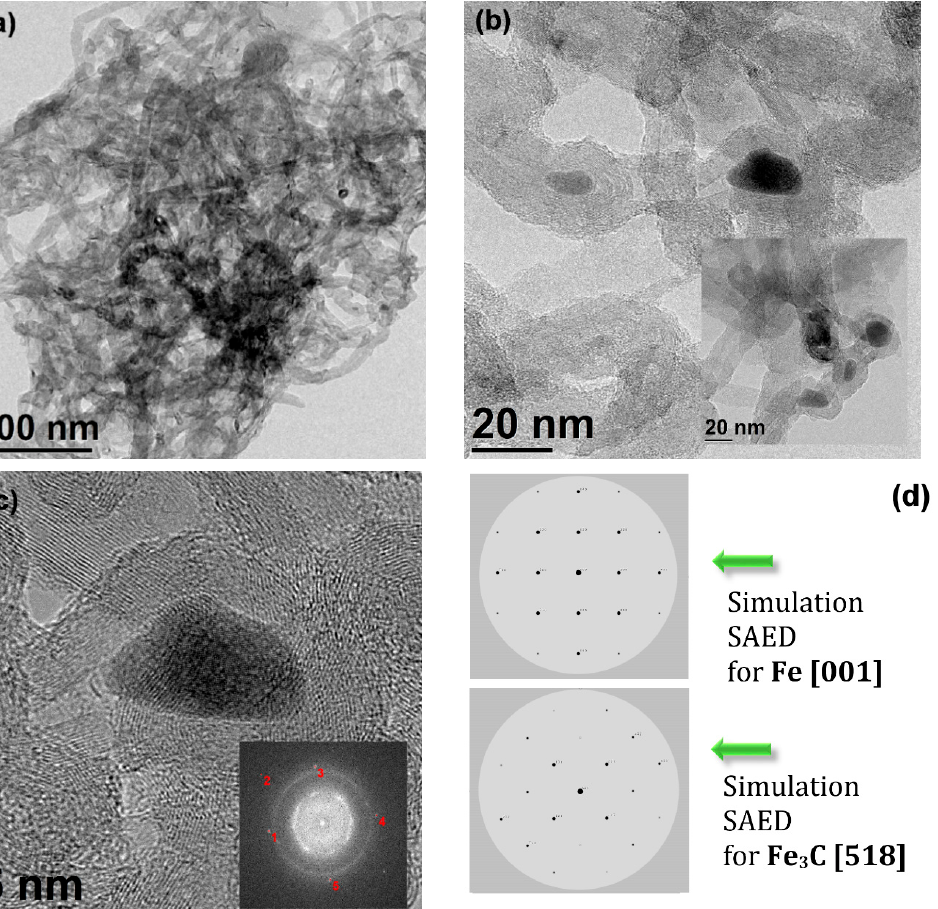
Figure 2. TEM image for pristine f-MWCNTs ( a ) entangled nanotubes; ( b ) nanotubes with visible Fe-based catalyst residues; ( c ) Fe-based nanoparticle with FFT analysis placed as insert; ( d ) selection area electron diffraction (SAED) pattern simulation of Fe [001] and Fe 3 C [518] phases.